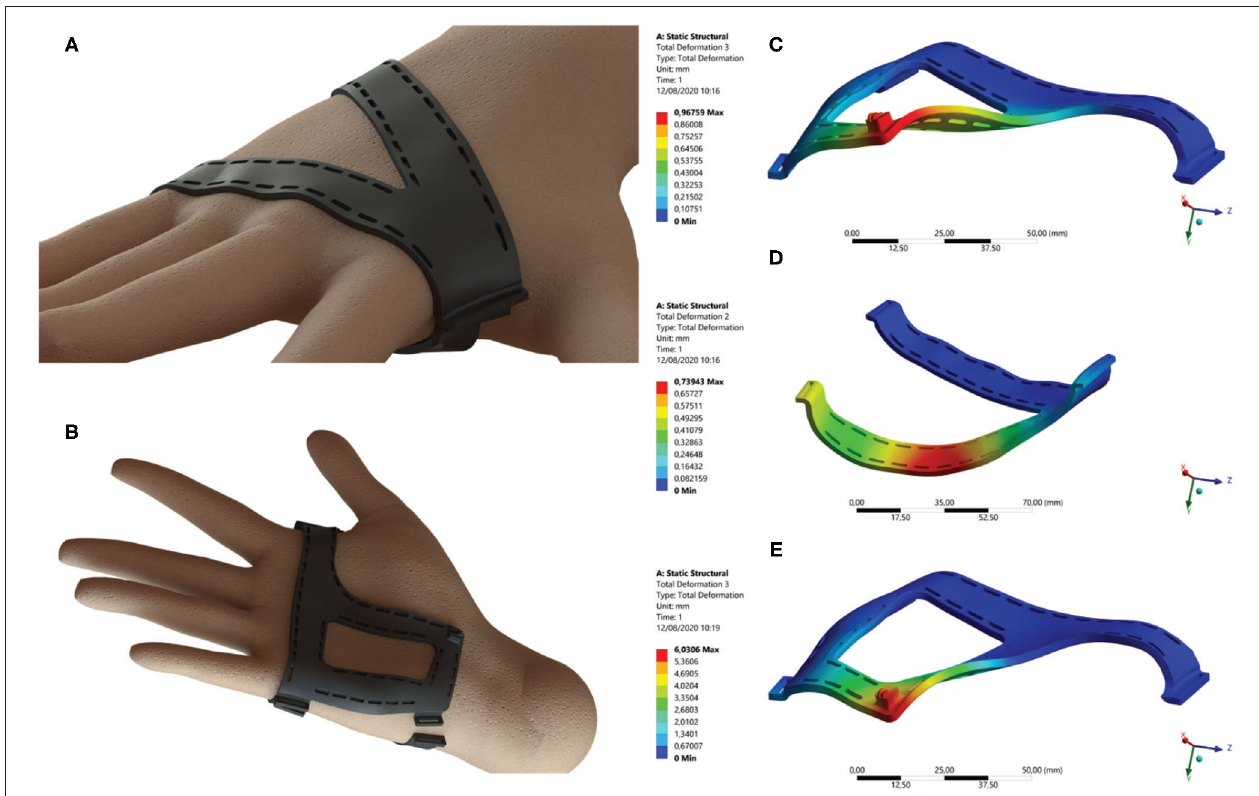
FIGURE 3 | (A,B) CAD renderings of the three-dimensional (3D)-printed ergonomic supports. (C,D) Fem analysis with a load of 10 N applied on the supports by the hand. Estimated average stiffnesses: (C) : 10.33 N/mm; (D) : 13.53 N/mm. (E) : Fem analysis with a load of 80 N applied on the support by the cable tendon. Estimated average stiffness: 13.27 N/mm. Stiffnesses values are compatible with the needed mechanical performance but, at the same time, allow the supports to be compliant enough to compensate for misalignment